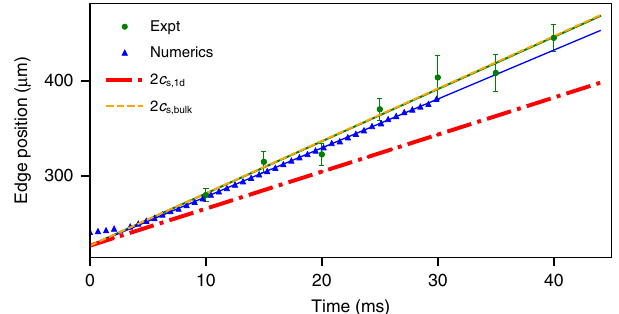
Fig. 7 Rarefaction waves. A BEC initially con fi ned to the left half of the trap is suddenly allowed to spread to the right. The plot shows the edge position vs. time, where experiment (green dots) and numerics (blue triangles) are plotted overlaid with expected results for 2 c s,bulk (orange dashed) and 2 c s,1d (red dot-dashed). Experimental data are mean ± s.d. for fi ve runs at each measured time, where the green and blue solid lines are best fi ts to experiment and numerics, respectively. See text for more